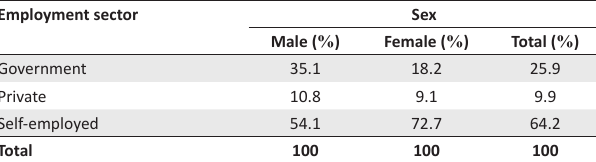
TABLE 4: Employment sector by sex ( N = 81 Females 44 and males 37). Employment sector TABLE 5: Training and promotion of workers in the government sector by sex ( % ).